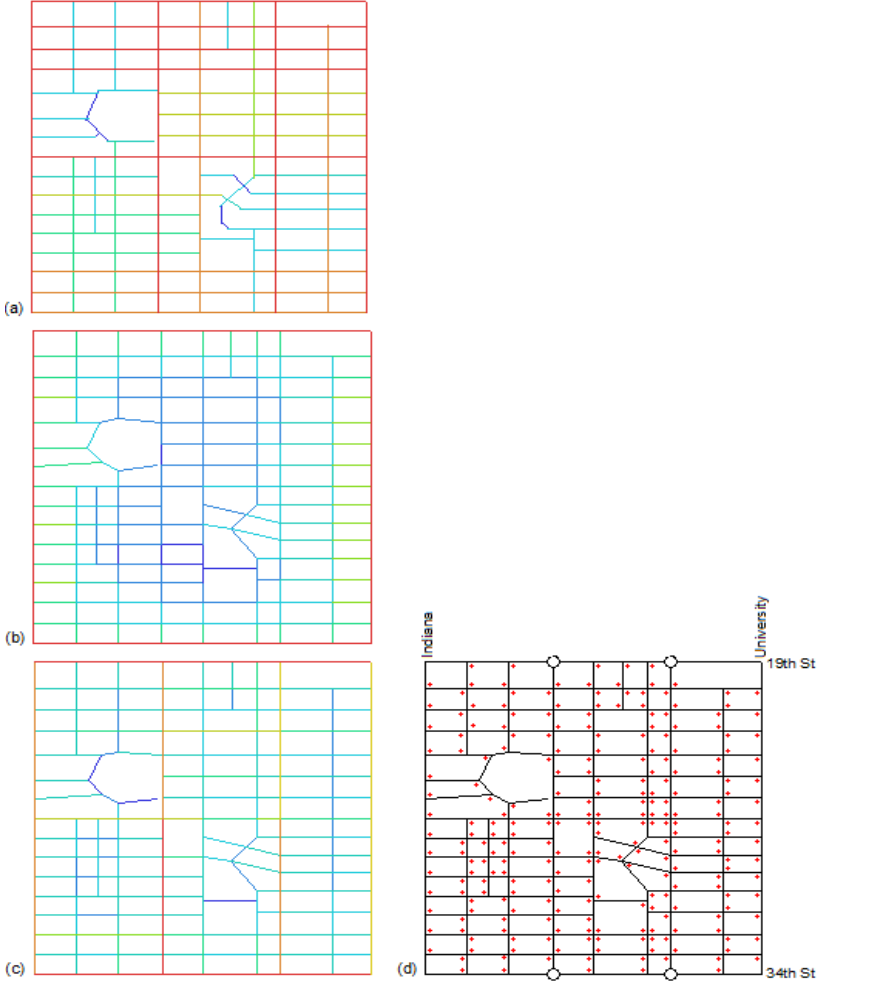
Figure 5. Integration maps of Tech Terrace (source: Paul, 2009); integration reduces as the color of the lines changes from red to blue. (a) Axial analysis, (b) type 1 unit-segment analysis, (c) type 2 unit-segment analysis, (d) locations of stop or yield